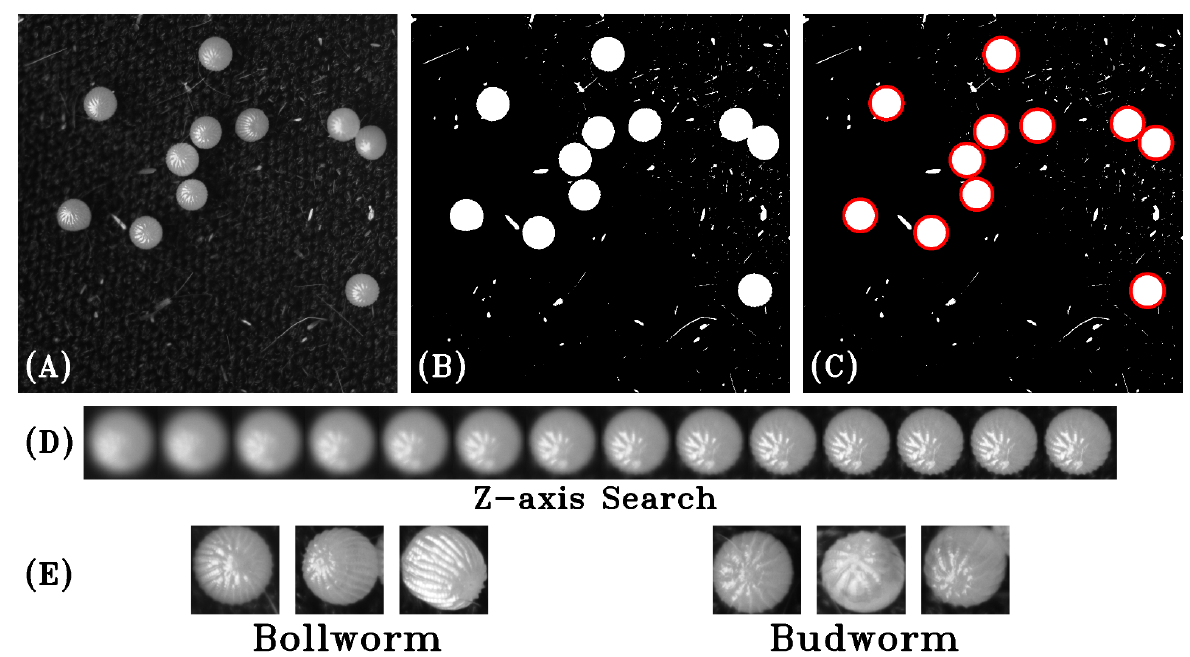
Figure 2. Each grayscale image ( A ) was passed through a binary pixel intensity filter transforming values below a threshold to zero (black) and pixels above the threshold to 255 (white) generating a mask highlighting the caterpillar eggs of interest before ( B ) a Hough circle detection algorithm was used to locate the eggs as outlined in red ( C ). Once the circle is located, the Z -axis of the image stack was searched for the most in-focus sample of the egg ( D ) and the centroid location used to crop a 224 × 224 region around the in-focus egg. Final images of H. zea eggs (left) and C. virescens eggs (right) ( E ) were organized into training, validation and test sets for model training and evaluation.